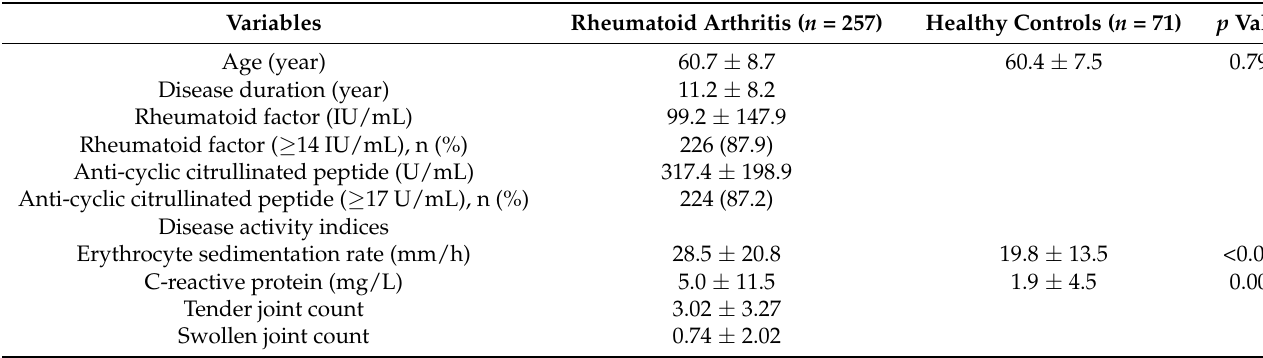
Table 1. General characteristics of study